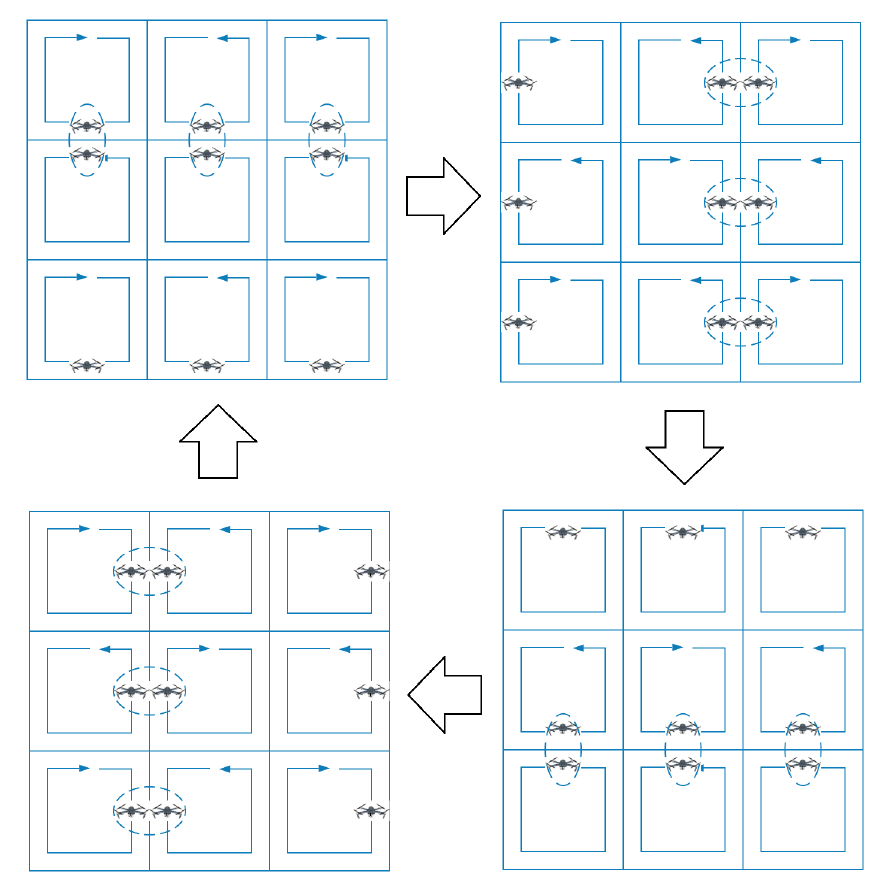
Figure 5. A synchronized multi-UAV system performing an area partitioning strategy, where neighbor UAVs patrol their closed paths in opposite directions. Each UAV meets periodically with each of its